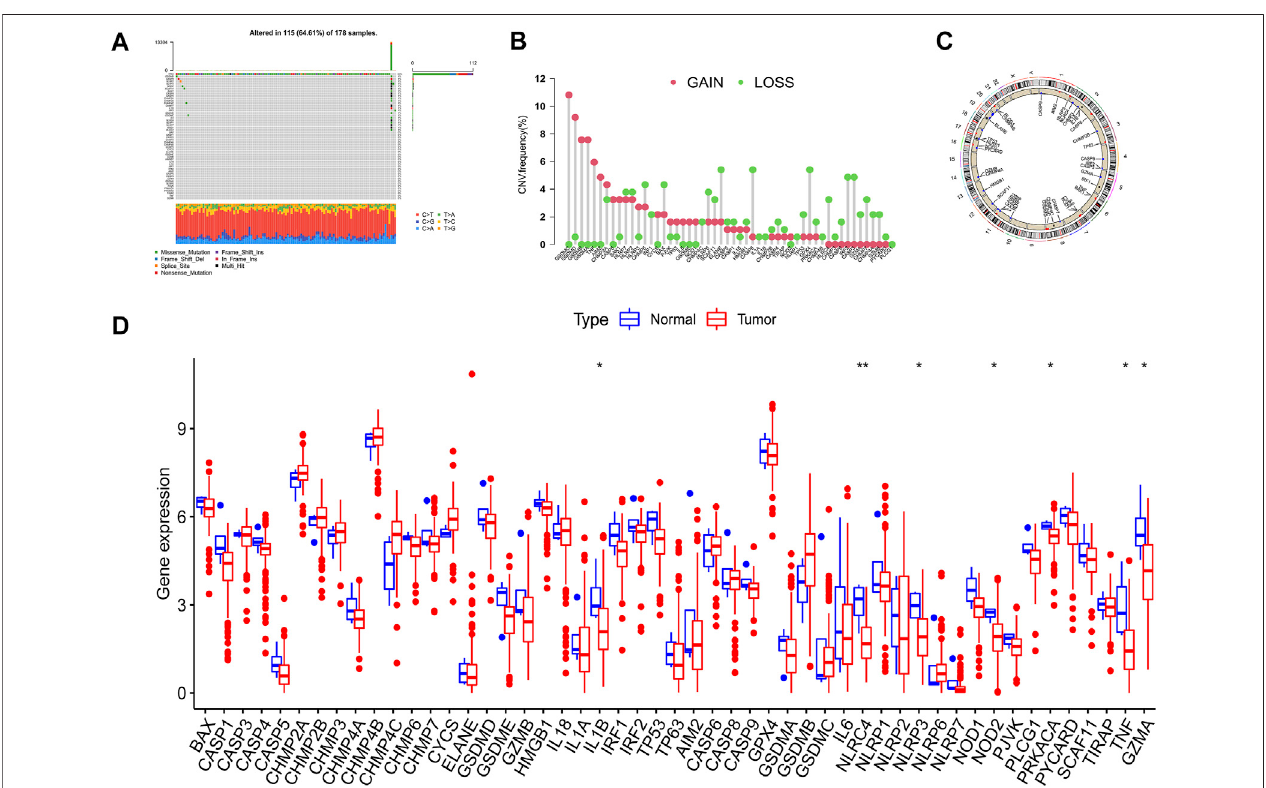
FIGURE 2 | Variation feature of 52 pyroptosis-related genes (PRGs) in pancreatic adenocarcinoma (PAAD). (A) Somatic mutation statistics: The overall mutation frequency was 64.61% (115 in 178 samples), TP53 accounted for the highest alteration frequency, and missense mutation was the predominant alternation type. (B) Copy number variation (CNV) analysis: CNV alteration was common among these PRGs, GSDMC, GSDMD, GSDMB, and GSDMA performed with CNV gain primarily, ELANE, CASP9, and GPX4 mainly presented with CNV loss. (C) Chromosomal location of PRGs. (D) The expression level of PRGs in normal and neoplastic samples was displayed by boxplot (* p < 0.05; ** p < 0.01).